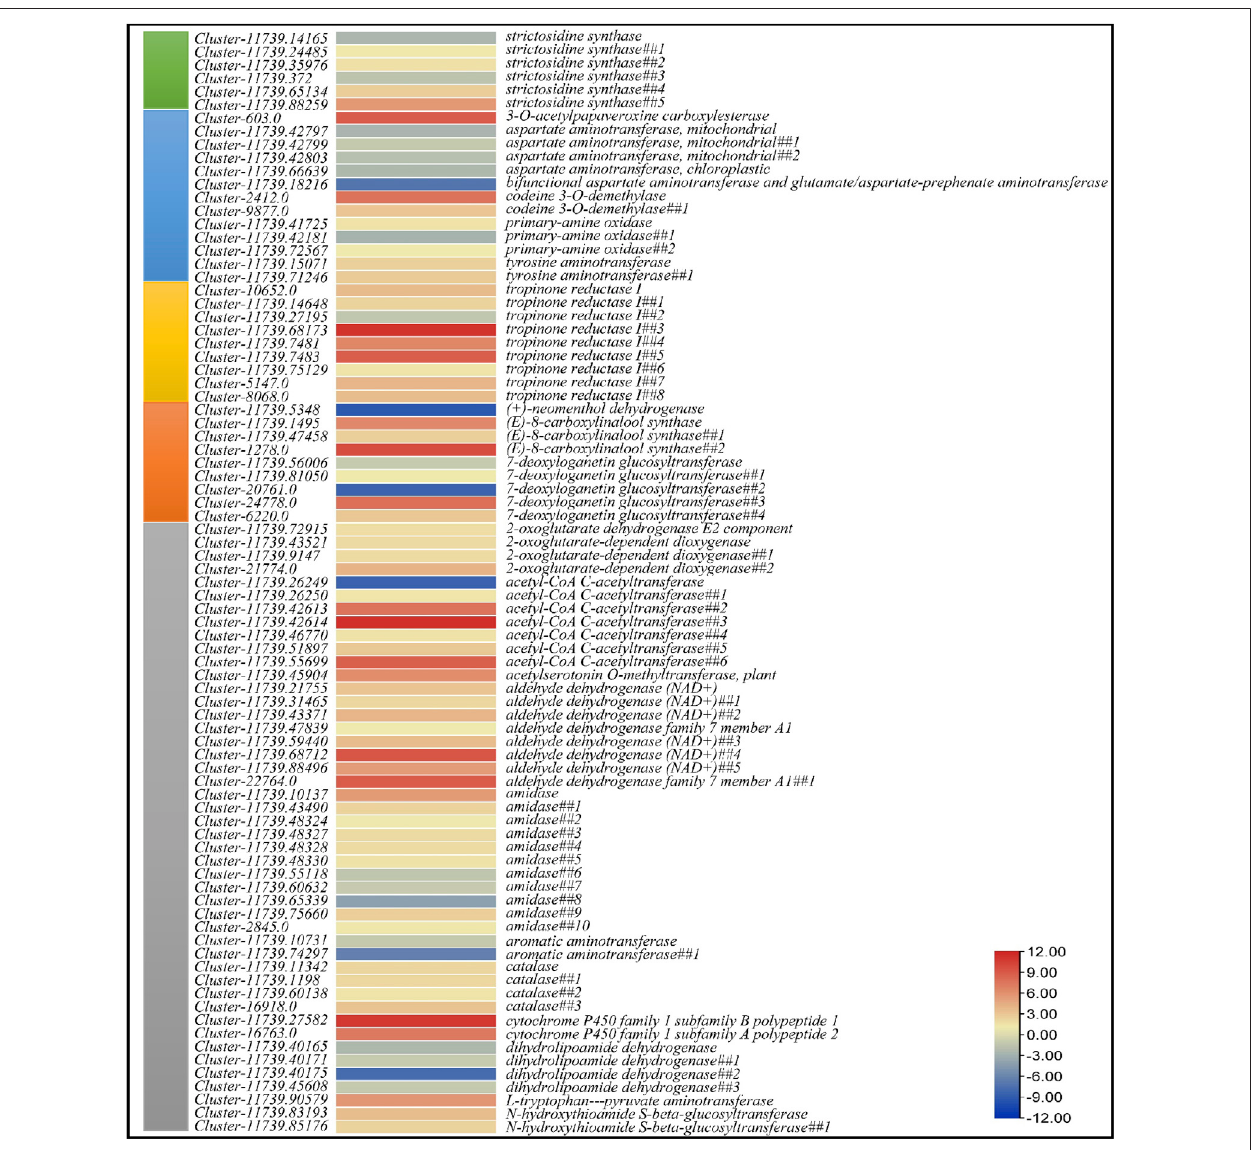
FIGURE4| Heatmapoflog2foldchangevaluesofthedifferentiallyexpressedgenesinIndolealkaloidbiosynthesis(green),Isoquinolinealkaloidbiosynthesis(blue), Tropane, piperidine and pyridine alkaloid biosynthesis (dark yellow), Monoterpenoid biosynthesis (orange), and Tryptophan metabolism (grey) pathways.